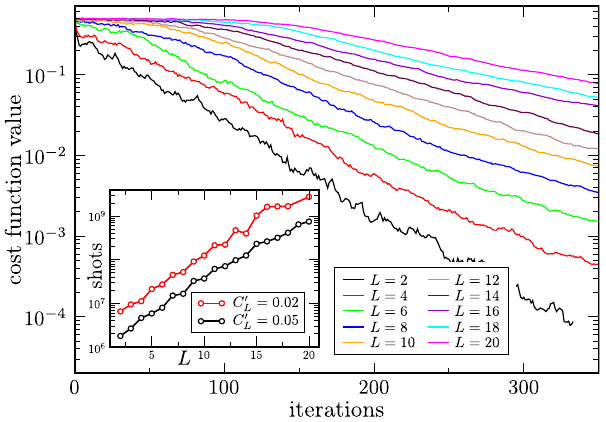
Fig. 6 Local cost C 0 versus number of iterations for the quantum L autoencoder problem in Eqs. (25 – 26) with n B = 10. Each curve corresponds to a different number of layers L in the ansatz of Fig. 4 with L = 2, … , 20. Curves were averaged over 9 instances of the autoencoder. As the number of layers increases, the optimization becomes harder. Inset: Number of shots needed to reach cost values of C 0 ¼ 0 : 02 and C 0 ¼ 0 : 05 L L versus number of layers L . As L increases the number of shots needed to reach the indicated cost values appears to increase